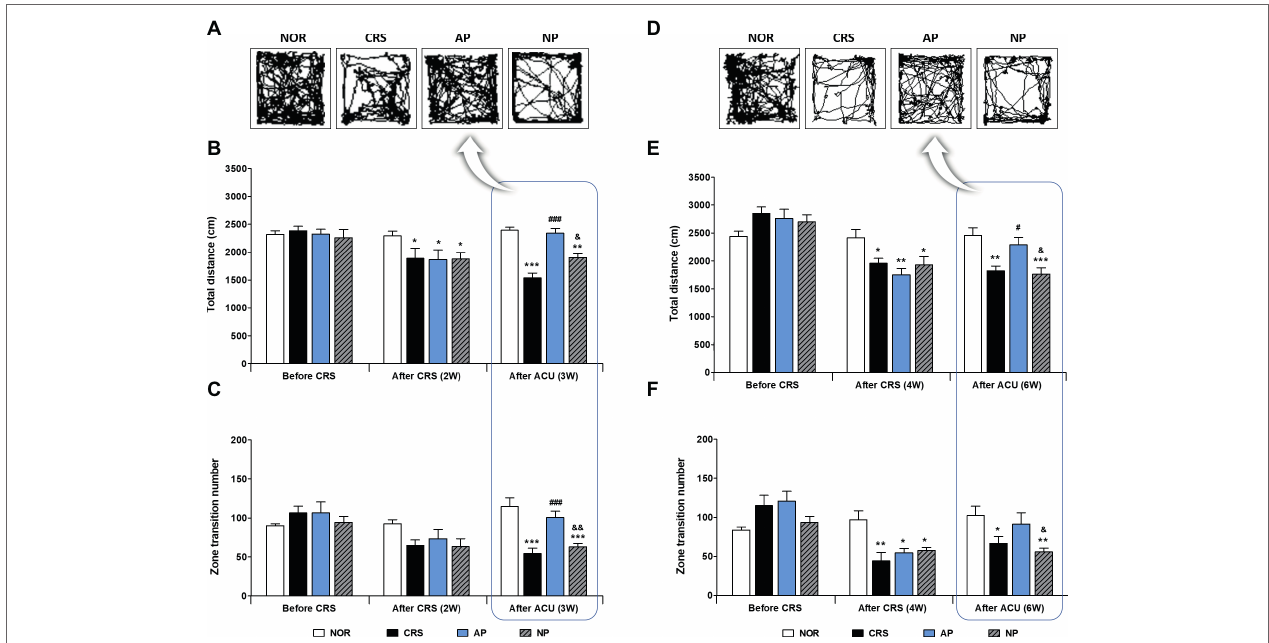
FIGURE 2 | Acupuncture treatment at the AP (KI10·LR8·LU8·LR4) can reverse chronic restraint stress (CRS)-induced depressive-like behavior, as compared to non-acupoint treatment. Acupuncture treatment at KI10·LR8·LU8·LR4 significantly reversed the decrease in the total distance and the number of zone transitions caused by CRS (AP vs. CRS and non-acupoint treatment group) in both the 2-week (A–C) and 4-week CRS models (D–F) . NOR, normal; AP, CRS and acupuncture treatment at KI10·LR8·LU8·LR4; NP, CRS and acupuncture treatment at non-acupoints on the hips. * p < 0.05, ** p < 0.01, *** p < 0.001 vs. NOR.